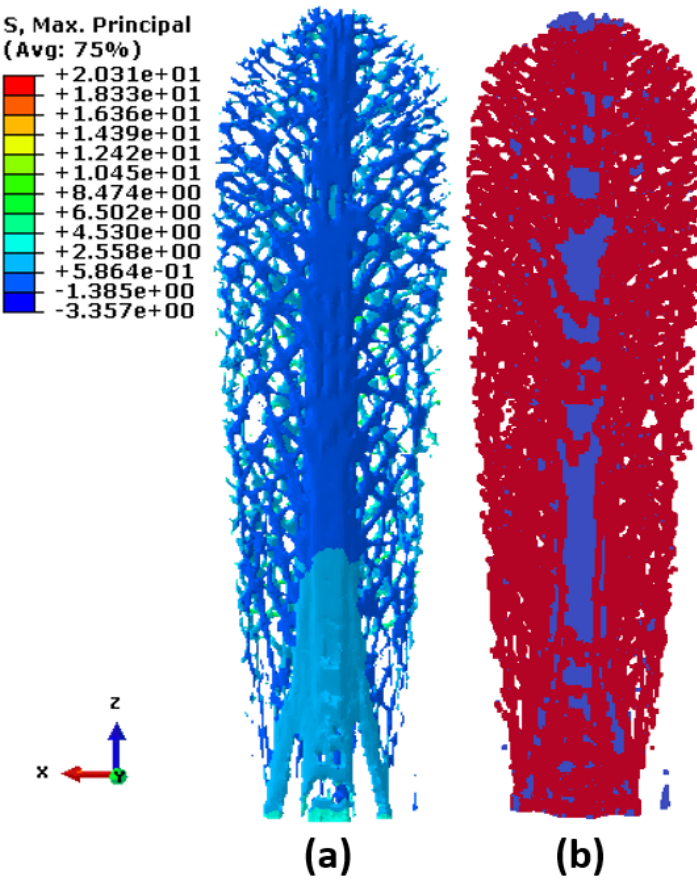
Figure 17. Hard cartilage of paddlefish rostrum. ( a ) Maximum principal stress obtained from finite element analysis. ( b ) Minimum cut obtained from mathematical analysis on top surface of rostrum’s hard cartilage. Nodes are colored by their respective locations on the source (red) or sink (blue) side of the minimum cut.